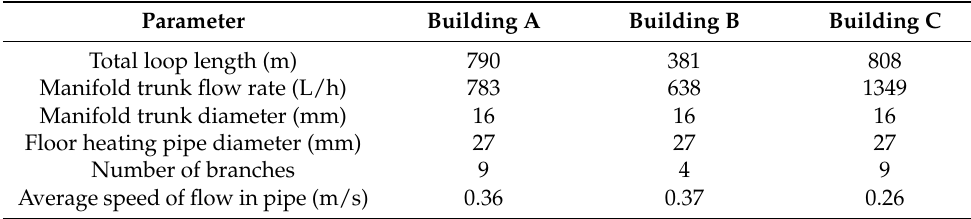
Table 7. Characteristics of floor heating system of the buildings.